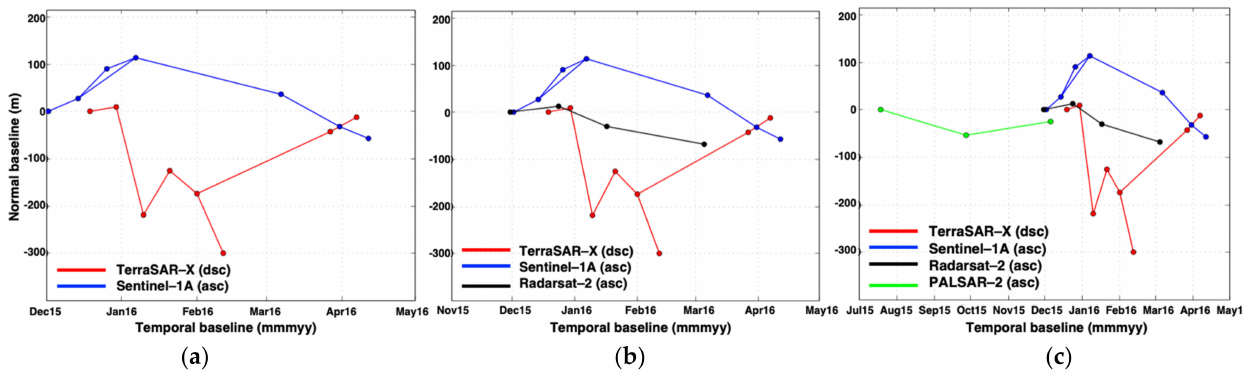
Figure 8. The baseline configuration of ( a ) the TerraSAR–X and Sentinel-1A datasets, ( b ) the TerraSAR–X and Sentinel-1A datasets and Radarsat-2, and ( c ) the TerraSAR–X and Sentinel-1A datasets, Radarsat-2, and